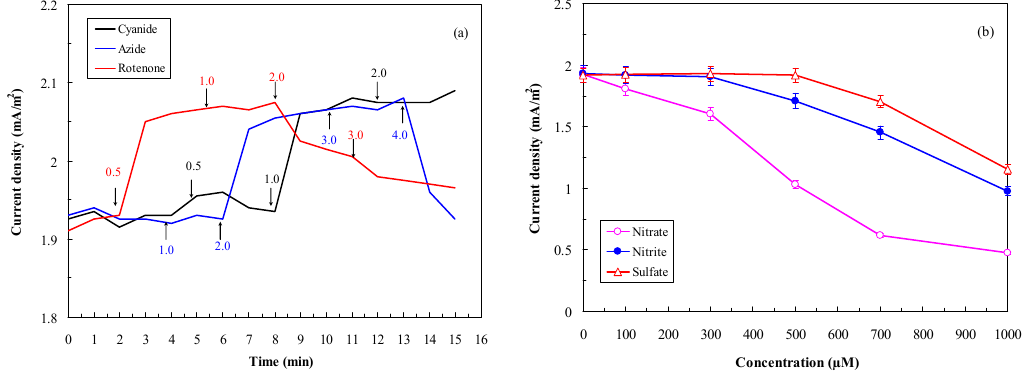
Figure 5. Effect of ( a ) Respiratory inhibitors (cyanide, azide, rotenone); ( b ) Electron acceptors (nitrate, nitrite, and sulfate) in the influent on the MFC performance (GGA concentration: 100 mg/L as BOD 5 ; LRT: 4 h; GRT: 6 min; n = 3).